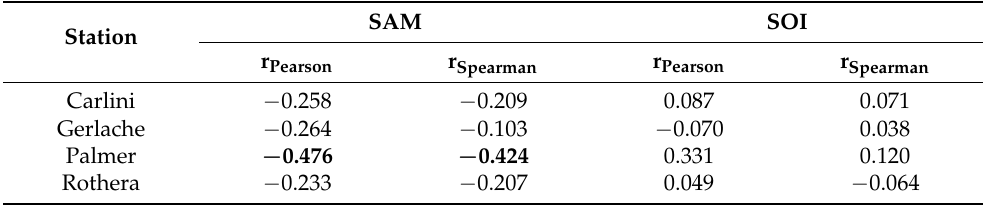
Table 4. Correlation analyses between Z SST and Z SAM or Z SOI . Values of Pearson’s (r Pearson ) and Spearman’s (r Spearman ) correlation coefficients are shown. Statistically significant values are shown in boldface. Threshold critical values [44,45] for alpha error = 0.05 and n = 20 are r Pearson = 0.444 and r Spearman =